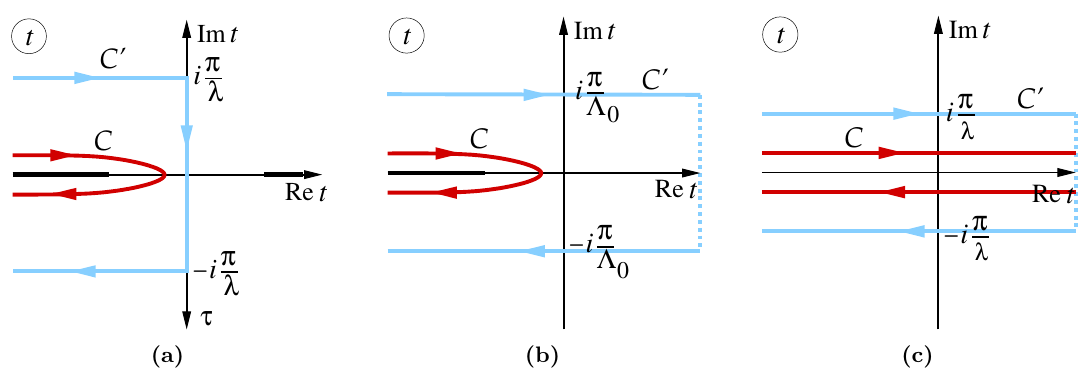
Figure 7. Structure of the thermal bounce in the complex time plane. (a) Low temperature solutions at λ < Λ correspond to periodic instantons in Euclidean time. At real t > 0 they describe 0 run-away of the field ϕ to the true vacuum at ϕ = + ∞ . (b) The bounce solution at λ = Λ tends to 0 the sphaleron at Re t → + ∞ . (c) Solutions at λ > Λ describe tunneling onto the sphaleron. They 0 are given by different analytic functions on the upper and lower parts of the contour C that runs from t = −∞ to t = + ∞ and backward. See the text for more